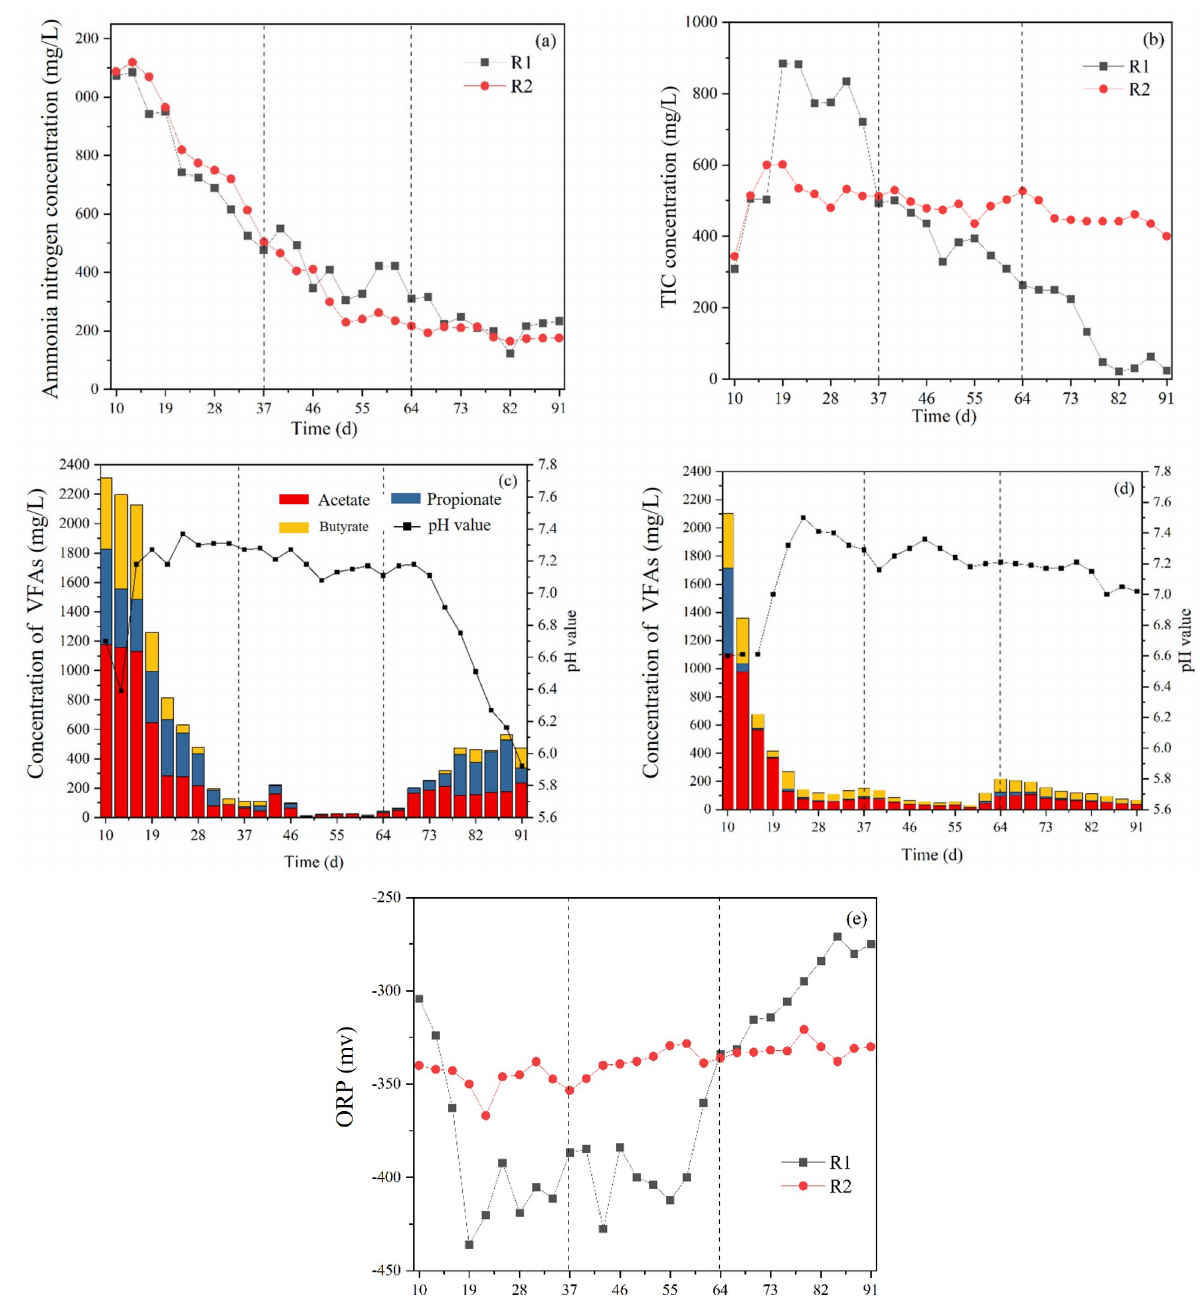
Figure 2. Concentration of ammonia nitrogen ( a ); concentration of total inorganic carbon ( b ); con- centration of volatile fatty acids and pH value of R1( c ) and R2( d ); ORP ( e ); in Phase Ⅰ –Phase Ⅲ , respectively, had organic load rates of 2, 3, and 4 gTS/(Lreactor·d). The concentration of ammonia nitrogen decreased gradually from ~1100 mg/L to ~200 mg/L during the whole AD process. With the increase of OLR, the TIC concentration of R1 decreased from 883.45 mg/L to 24.06 mg/L; R2 decreased slowly but remained at 500 ± 100 mg/L. A stable TIC environment was very important for the stability of corn stalk anaerobic digestion [27]. The variation trend of VFAs concentration was similar to that of ammonia nitrogen, which decreased significantly, from 2310.99 mg/L and 2101.90 mg/L to 14.5 and 29.1 mg/L, respectively. At the end of phase Ⅱ , the VFAs concentrations in both groups were low. The VFAs concentration of R1 increased, when OLR was 4 gTS/(Lreac- tor·d), and pH value dropped to 5.92,which inhibited methanogens metabolism. The peak pH values of R2 decreased gradually from 7.50 to 7.02. The ORP of R1 and R2 increased, when OLR increased, and the variation of R1 was more significant from −436.10 to −271.70 mV, and the average values of R2 in three phases, which were maintained in a suitable range, were −347.90 mV, −336.90 mV and −331.10 mV, respectively. With the increase of OLR, the pH value and oxidation-reduction potential (ORP) of the reflux group remained 7.16 ± 0.23 and −338.71 mV ± 9.22, indicating that the system was relatively stable. 3.3. Microbiological Analysis during Biogas Production Process 3.3.1. Dynamics of Microbial Community Richness and Diversity The microbial diversity parameters, including Shannon, Simpson, Ace, and Chao 1, estimated at different phases of the AD systems are shown in Table 3. Table 3. Alpha diversity parameters of the microbial community during the anaerobic digestion process.